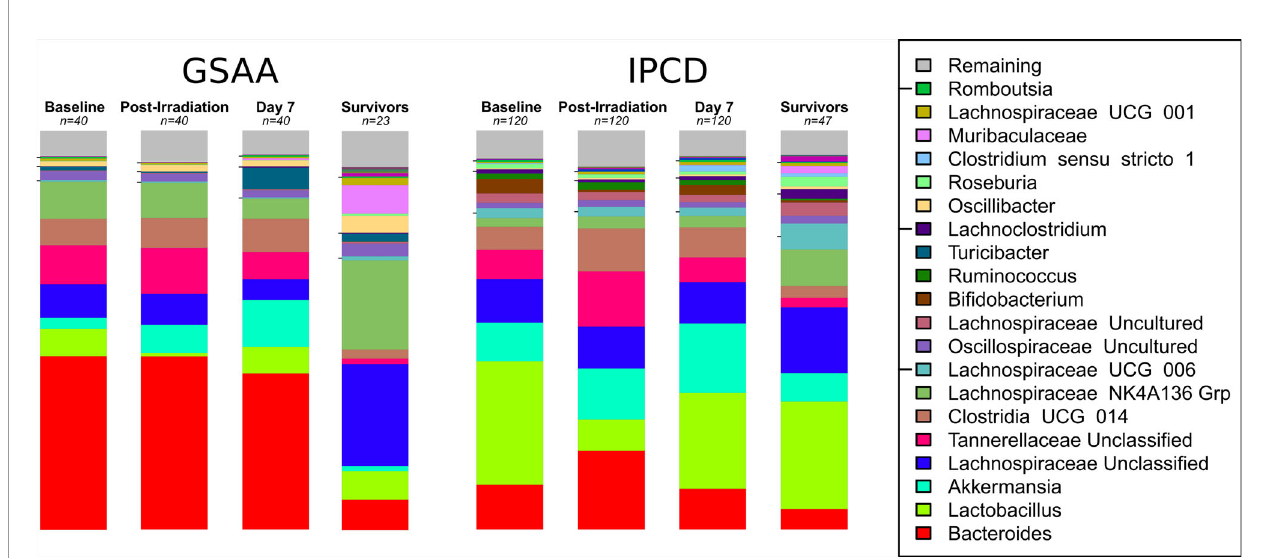
FIGURE 3 | Stacked Bar Chart of Microbiota at Key Time Points. The stacked bar charts represent the average relative abundance at each time point of the top taxa between both experiments. Experiment GSAA and IPCD (left and right, respectively), each have 4 time points depicted: Baseline (Day 0), Post-Irradiation (Day 1), Post-treatment but before any sacri fi ces (Day 7), and Survivors (Day 30). The taxa are ordered by decreasing average abundance across all samples from bottom ( Bacteroides ) to the top (Remaining). Taxa in the Remaining category represent multiple taxa with abundances too low to individually represent visually. The baseline, post-irradiation, and day 7 consist of n = 40 and n = 120 samples, for the GSAA and IPCD experiments, respectively. The stacked bar chart for the survivors only consisted of the n = 23 and n = 47 samples from the GSAA and IPCD experiments, respectively, so survivor bias will be present here. From these charts, the difference in the baseline, i.e. batch speci fi c differences, and their response to TBI can be qualitatively observed. Lactobacillus can be clearly seen to decrease in the post-irradiation samples, then recover by day 7. The taxonomic composition of the survivors have not returned to baseline.